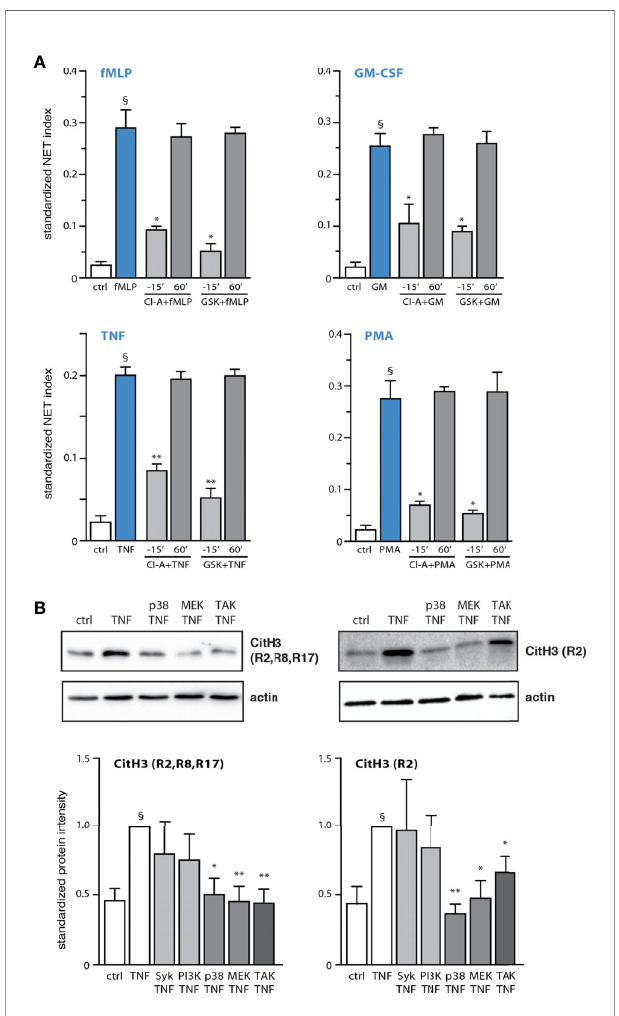
FIGURE 1 | PAD4 activation and histone citrullination are early events in NET generation and are controlled by kinases affecting early processes. (A) Neutrophils cultured on poly-L-lysine-coated coverslips were treated either before or after stimulation for the indicated times with 10 µM chloraminidine ( “ Cl-A ” , a general PAD inhibitor), 10 µM GSK484 (a PAD4 inhibitor), or their diluent (DMSO). The cells were stimulated for 4h in the absence ( “ ctrl ” ) or presence of 30 nM fMLP, 1 nM GM-CSF, 100 U/ml TNF a , or 50 nM PMA. NET formation was then assessed using PlaNET Blue, as described in Methods . Quantitative representation of these experiments, expressed as NET index. Mean ± s.e.m. from at least 3 independent experiments. *p < 0.05; **p < 0.01 vs stimulus alone. § p < 0.015 vs unstimulated cells. (B) Neutrophils cultured on poly-L-lysine-coated coverslips were pre-treated (15 min) with the following inhibitors or their diluent (DMSO): 10 µM piceatannol (Syk inhibitor); 10 µM LY294002 (PI3K inhibitor); 1 µM SB202190 (p38 MAPK inhibitor); 10 µM U0126 (MEK inhibitor); 1 µM (5Z)-7-oxozeaenol (TAK1 inhibitor). The cells were then further incubated for 10 min in the absence ( “ ctrl ” ) or presence of 100 U/ml TNF a . Samples were then processed for immunoblot detection of citrullin residues on histone H3, as depicted. A representative experiment is shown, along with a quantitative compilation of these experiments (mean ± s.e.m. from at least 4 independent experiments; *p < 0.05 vs stimulus alone; **p < 0.01 vs stimulus alone; § p < 0.005 vs unstimulated